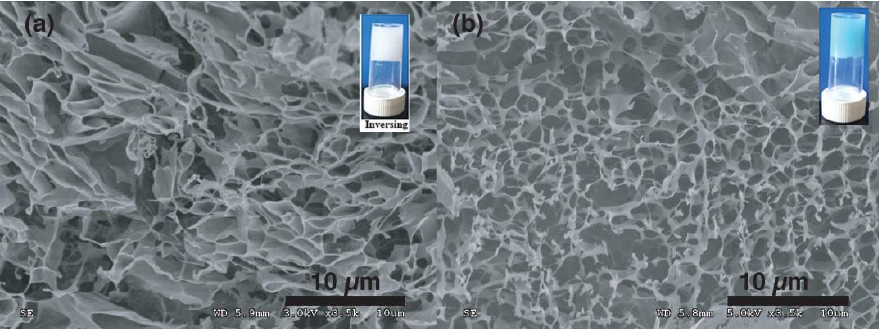
Figure 5. The cryo-SEM images of ( a ) the C18ADPA hydrogel and ( b ) the PHTrp-Cu-loaded